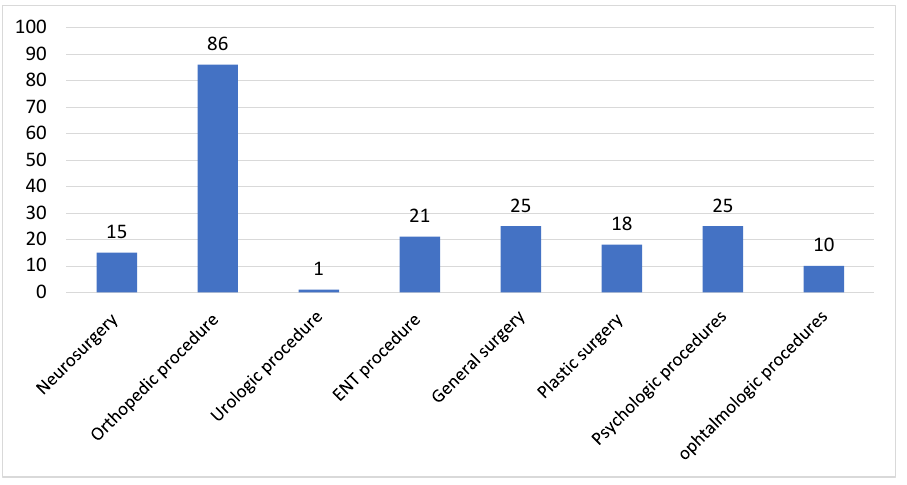
Figure 2. Number and Type of Procedures Performed for